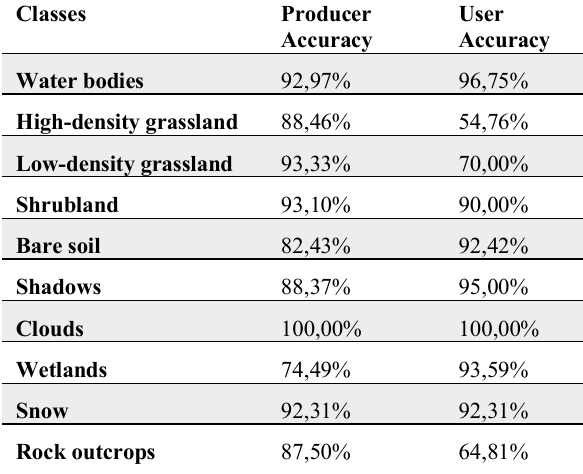
Table 2 Producer and User Accuracy of the MLC map. All the data collected in the field were uploaded in the web portal and made available for the further analysis.